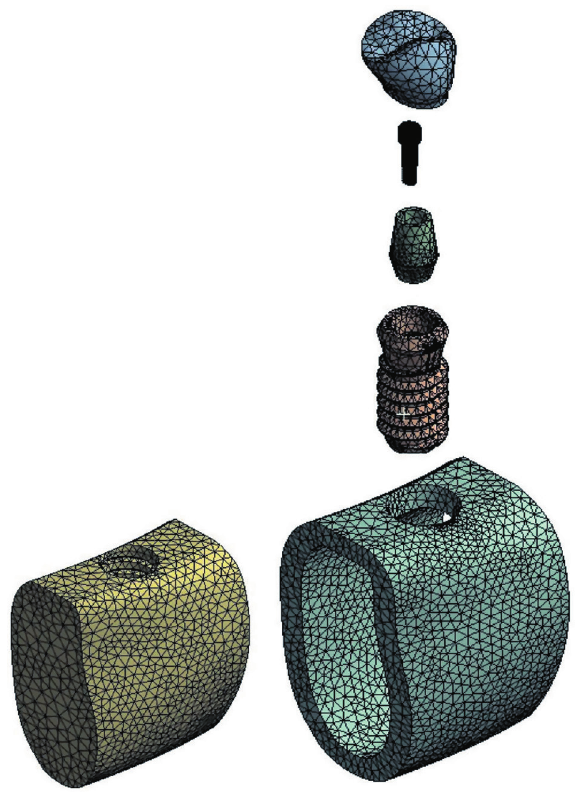
Figure 3- Bone-implant system mesh using tetrahedral quadratic